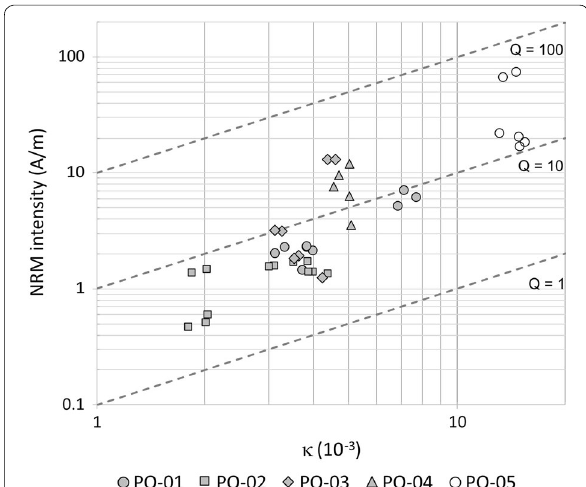
Fig. 6 Variation of the NRM intensity and magnetic susceptibility for the three studied lavas and scoria clast, together with lines of constant ratio ( Q NRM/ κ H ); the ratio between remanent and = · induced magnetizations, where κ is the initial magnetic susceptibility and H 33 Am − 1 the magnetic field =